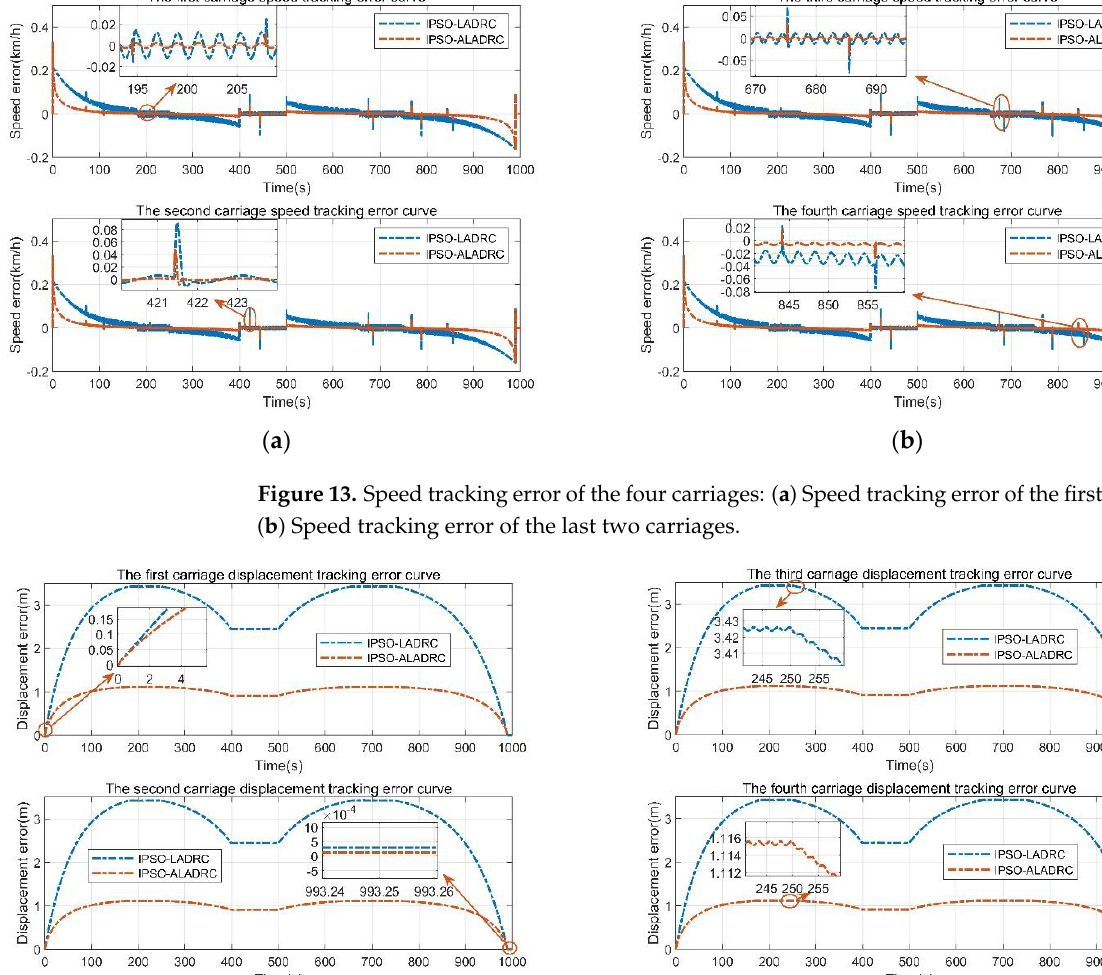
Figure 12. Change of time-varying coefficients.